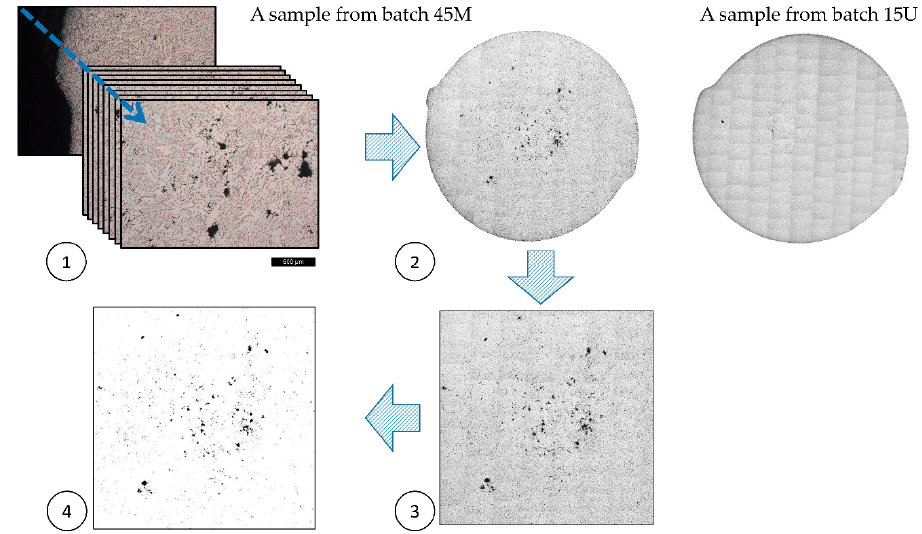
Figure 4. The followed method for calculating impurities and the associated porosity content at section A–A. ( 1 ) Obtaining microscope images for all the cross-section area at 50× magnification in each sample in the batch. ( 2 ) Combining and processing each sample images. ( 3 ) Extracting a central area form the combined image. ( 4 ) Processing each image by Fiji (ImageJ) software and reporting the average measurements of the samples in each batch.